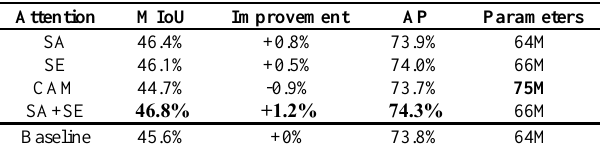
Table 1 . Comparison accuracy of different attention module on NYUv2.